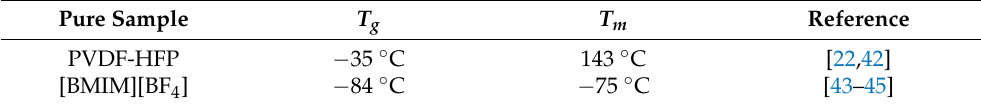
Table 1. Glass transition and melting temperature value for pure PVDF-HFP and [BMIM][BF 4 ].